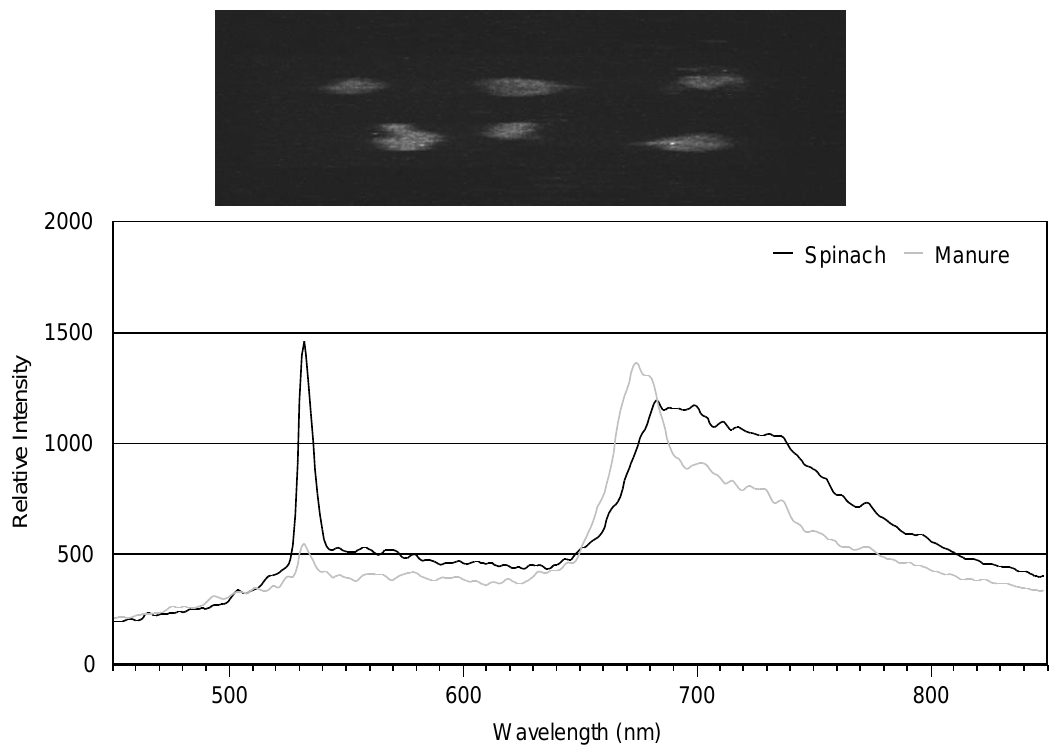
Figure 12. Fluorescence image at 673 nm using a gate delay of 5 ns and a gate width of 25 ns. The graph shows the representative spectra for spinach leaves and dairy manure. The peaks around 532 nm are spillover from the doublet frequency of the frequency-tripled laser.